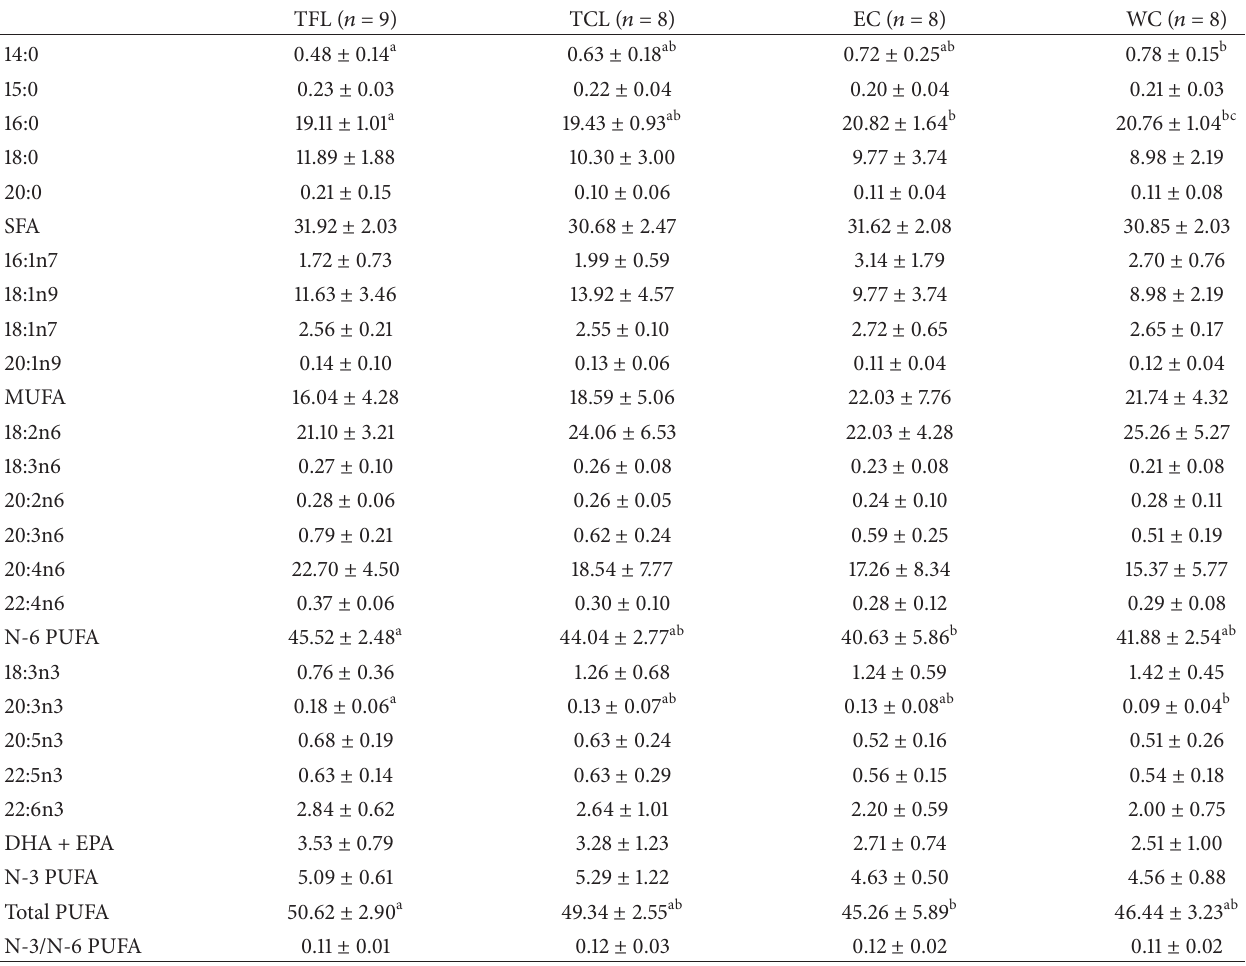
Table 5: Kidney total fatty acid profiles after consumption of TFL and